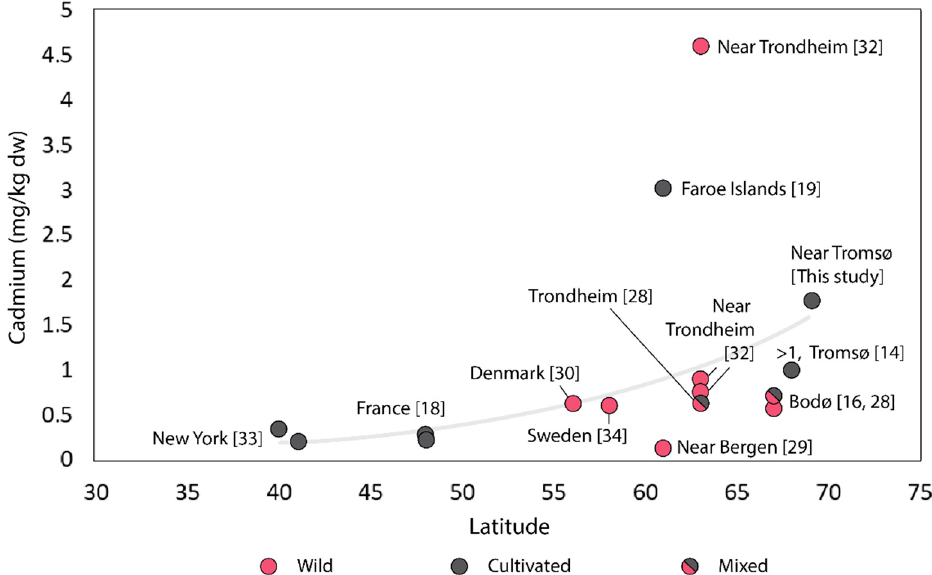
Figure 2. Cadmium content in wild and cultivated S. latissima grown at latitudes ranging from 40–69 ◦ N. Prepared using original data and data from the indicated literature.